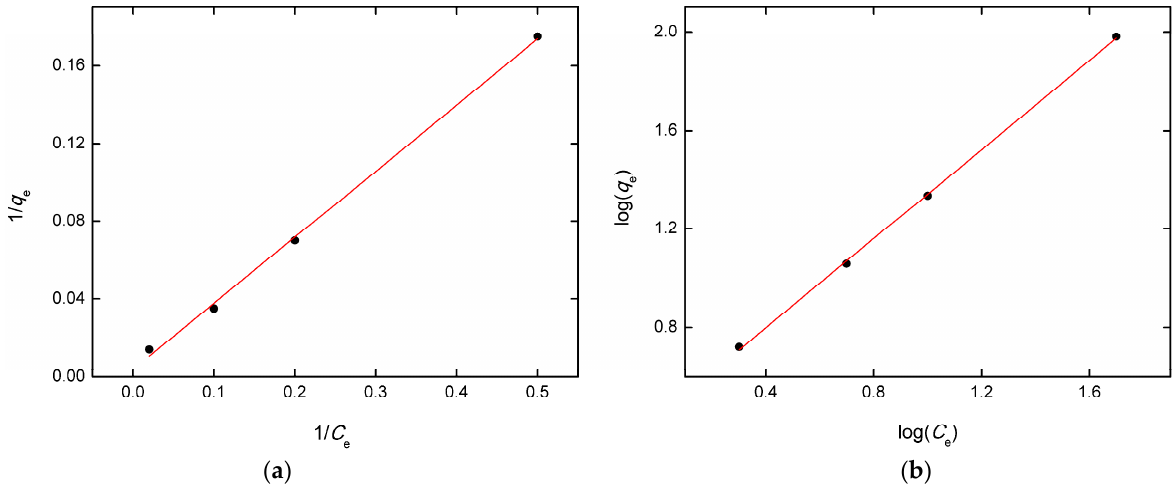
Figure 8. Langmuir ( a ) and Freundlich ( b ) isotherm plots for pH values equal to 5 and 1, respectively. Solid lines represent the fit to Equations (4) and (5), respectively. It is revealed that the decrease of pH enables the Freundlich isotherm as a better model for describing the equilibrium behavior of nitrate adsorption to Fe 3 O 4 @AgNPs.